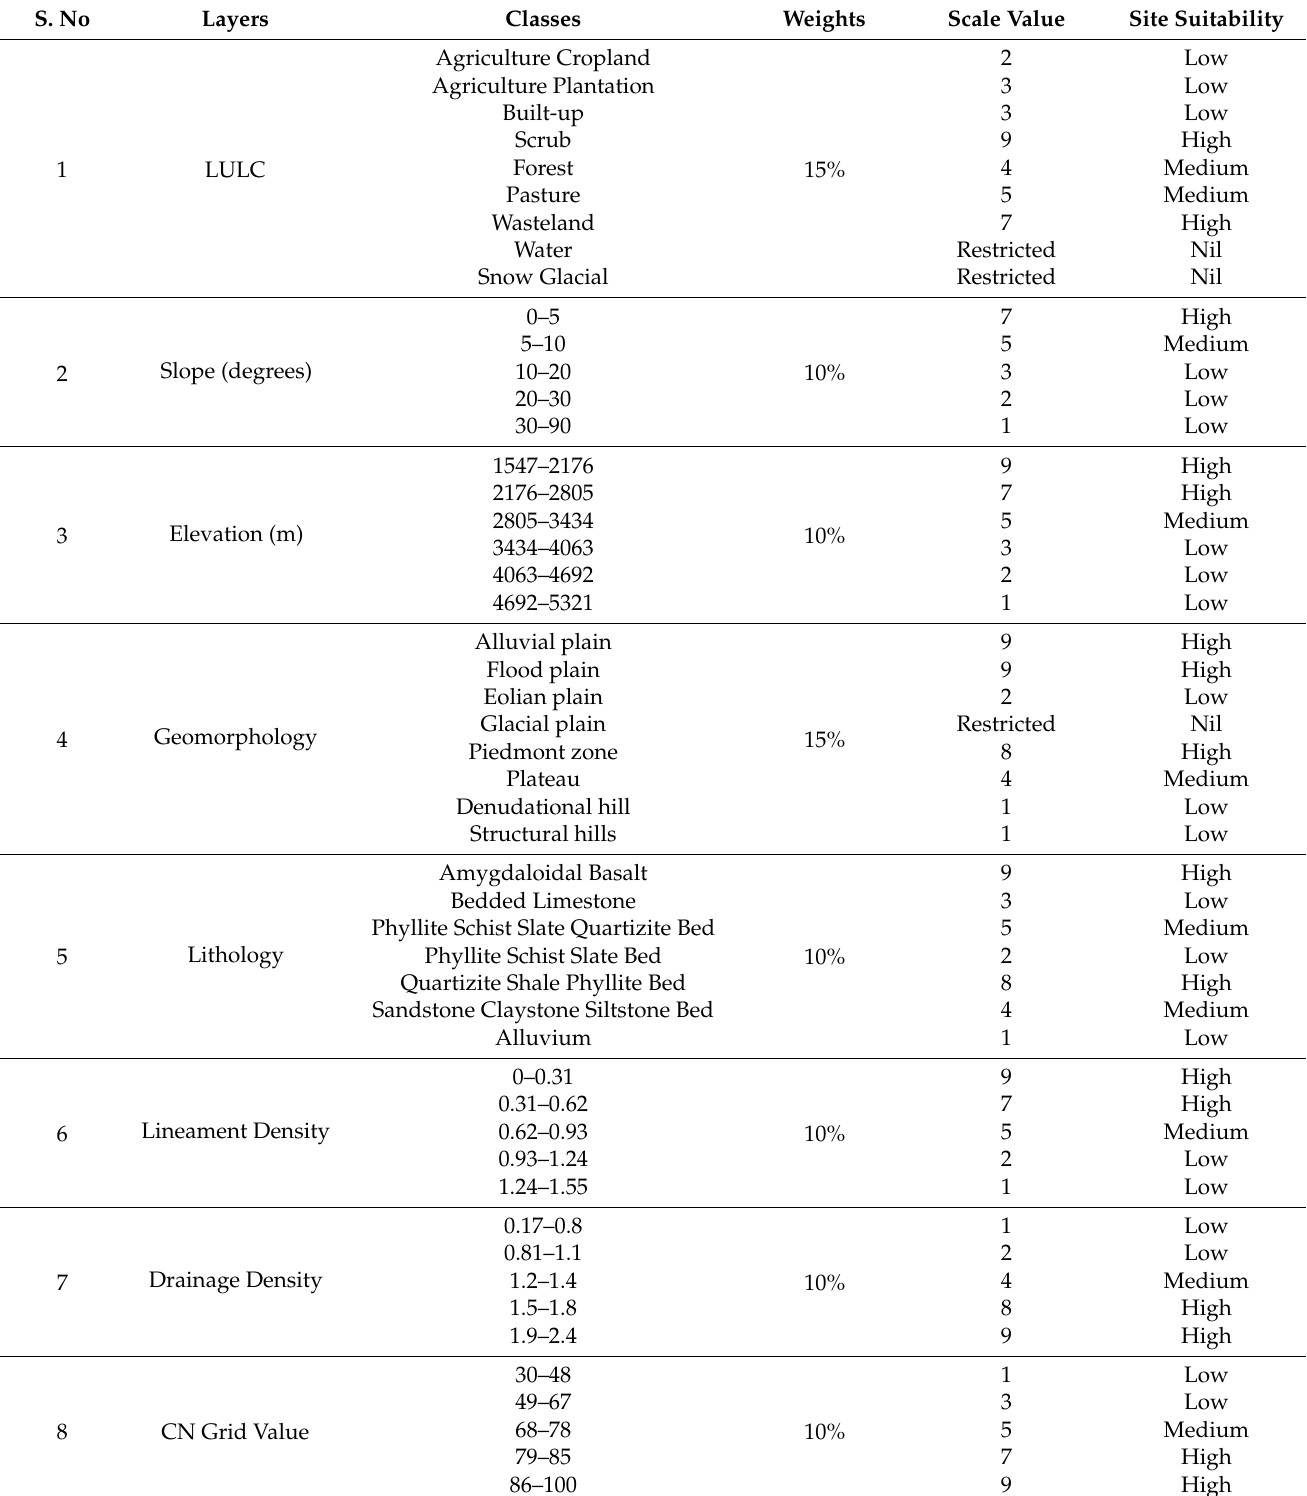
Table 3. Weightage and scale values for different thematic layers and their classes,